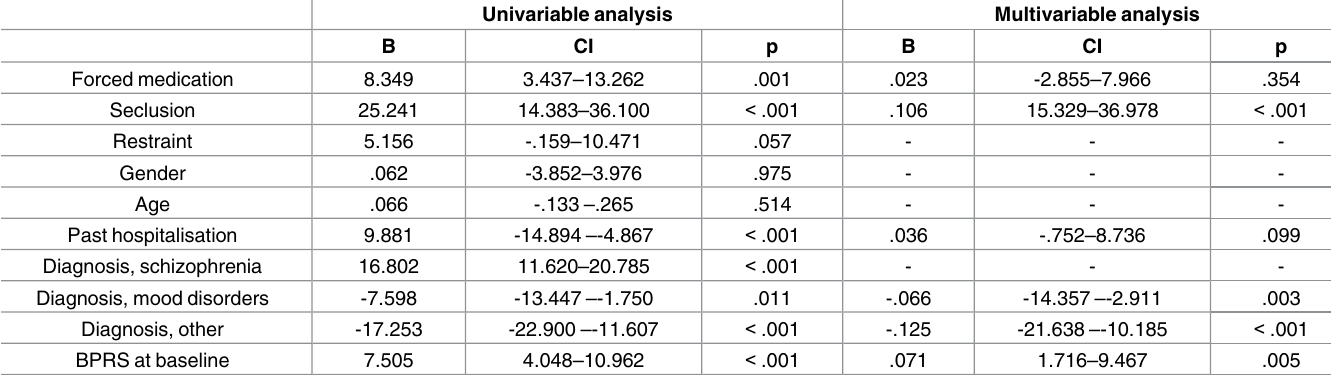
Table 2. Linear regression analysis of association between coercivemeasures(and other variables) and length of index